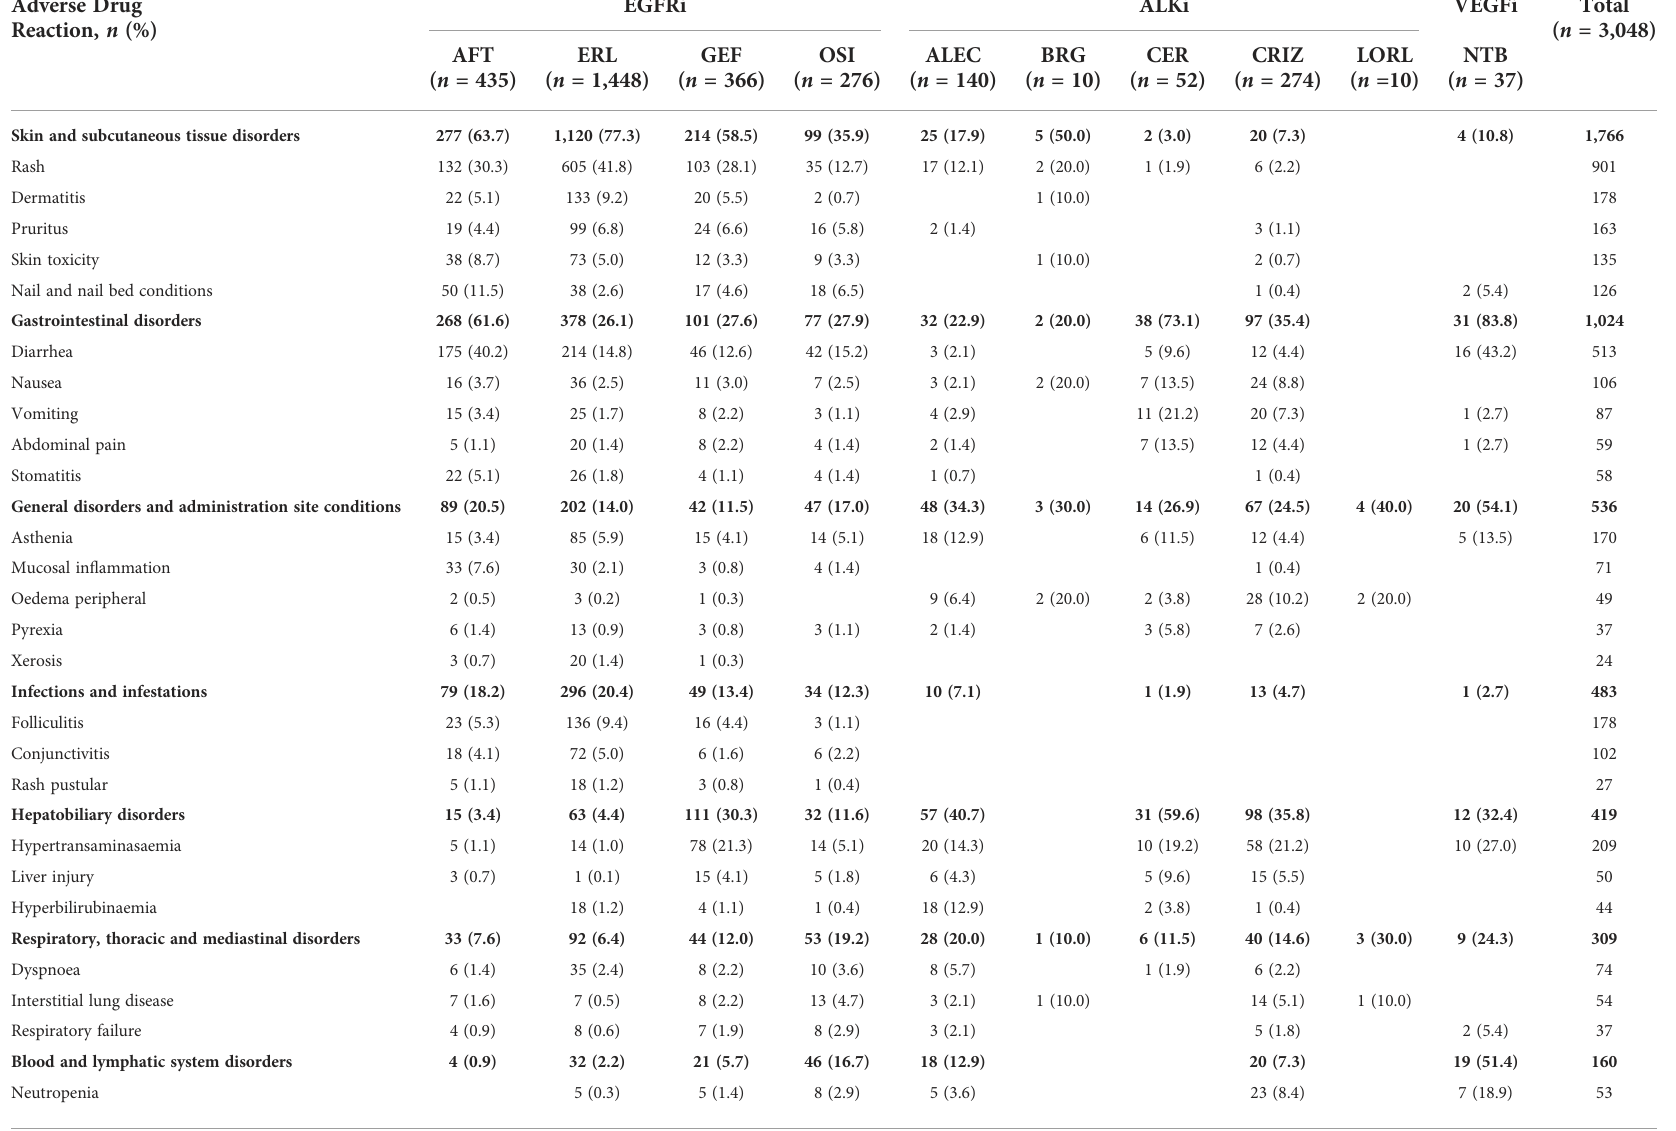
TABLE 2 Descriptions of main ADRs associated with TKIs for NSCLC treatment and reported into the RAM system. Adverse Drug Reaction, n